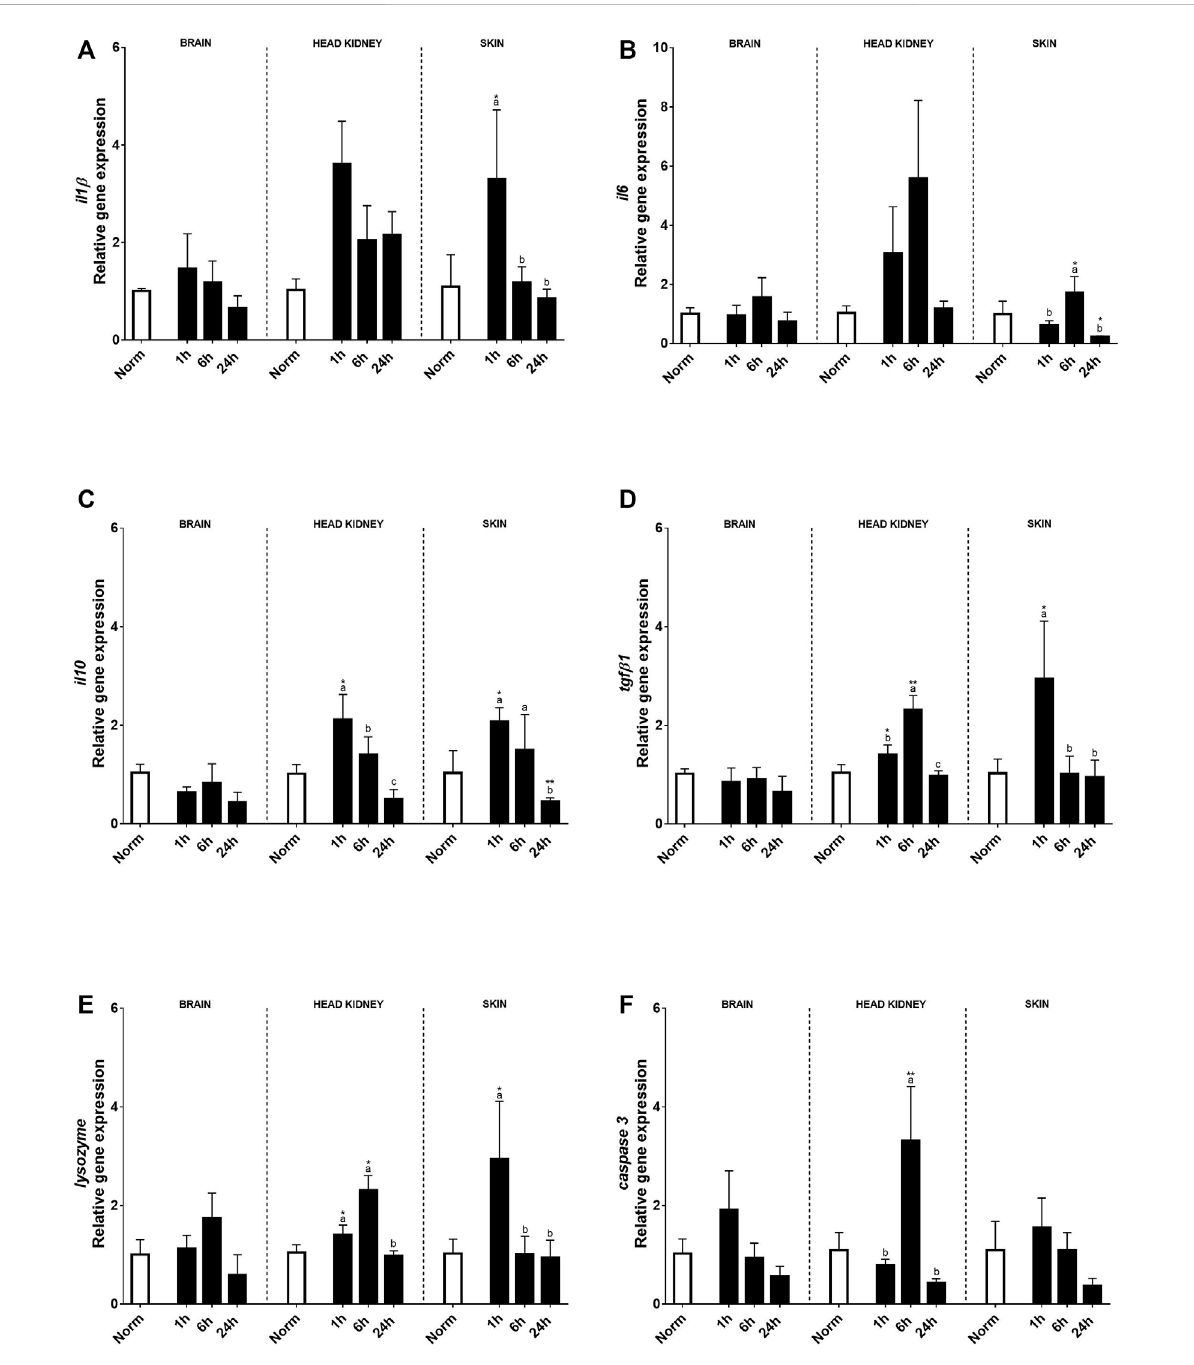
FIGURE 4 Transcript levels of pro-in fl ammatory (A) il1 β , (B) il6 , anti-in fl ammatory (C) il10 and (D) tgf β 1 , and innate immune response genes (E) lysozyme and (F) caspase 3 in rainbow trout brain, head kidney, and skin after normoxia and after acute hypoxia with different recovery times (1, 6, and 24 h). The values are presented as mean +SEM ( n = 8). Signi fi cant differences between time points after hypoxia are shown by letters; between hypoxia treated and normoxia are shown by * ( p < 0.05) or ** ( p <